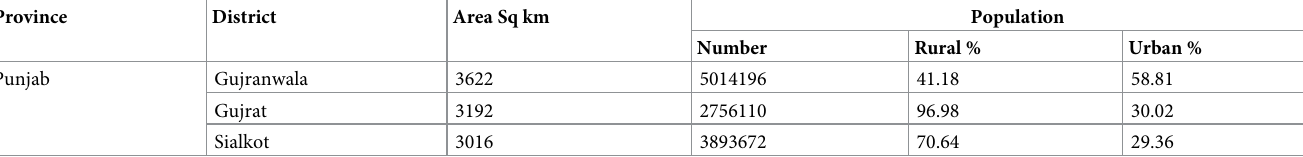
Table 1. Demographic characteristic of study area source: Pakistan bureau of statistics